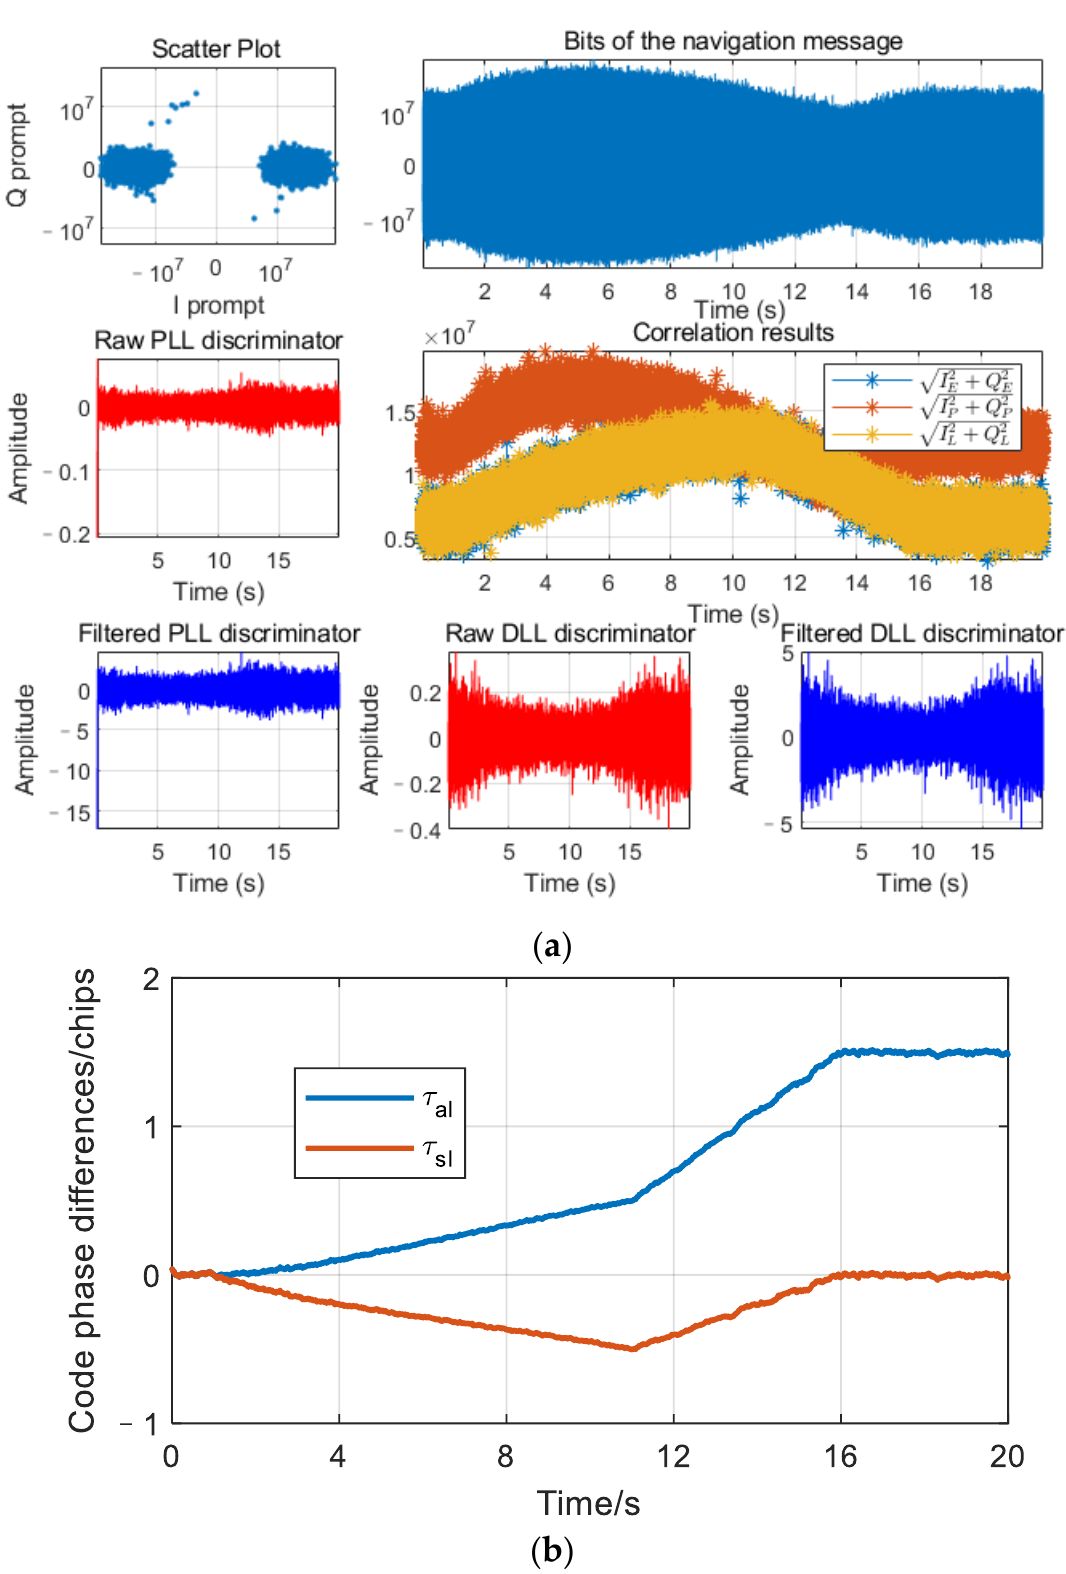
Figure 14. Results of the conventional Strategy 1 (C/N 0 = 50 dBHz, D = 1). ( a ) Obtained results of software receiver; ( b ) Code phase difference.